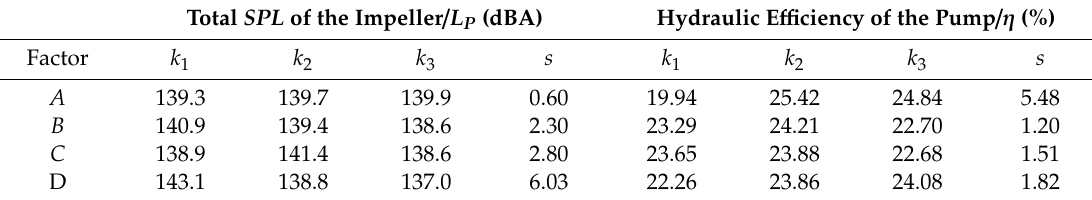
Table 12. Results of range